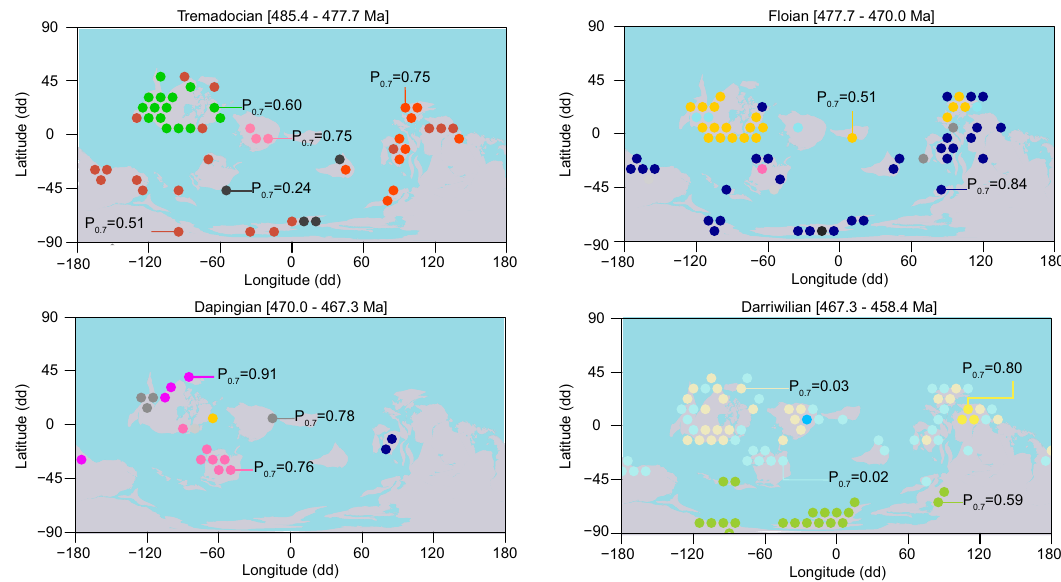
Fig. 6 Examples of evolutionary bioregions recovered at lower hierarchical levels. These modular structures form geographically coherent units that change through time and underlie the global marine mega-assemblages. Circles represent the center of the geographic cells colored by their module af fi liation (Supplementary Data 3). By recovering bioregions at lower hierarchical levels, we demonstrate that our multilayer approach captures temporal (inter-stage) relationships without destroying spatial (intra-stage)